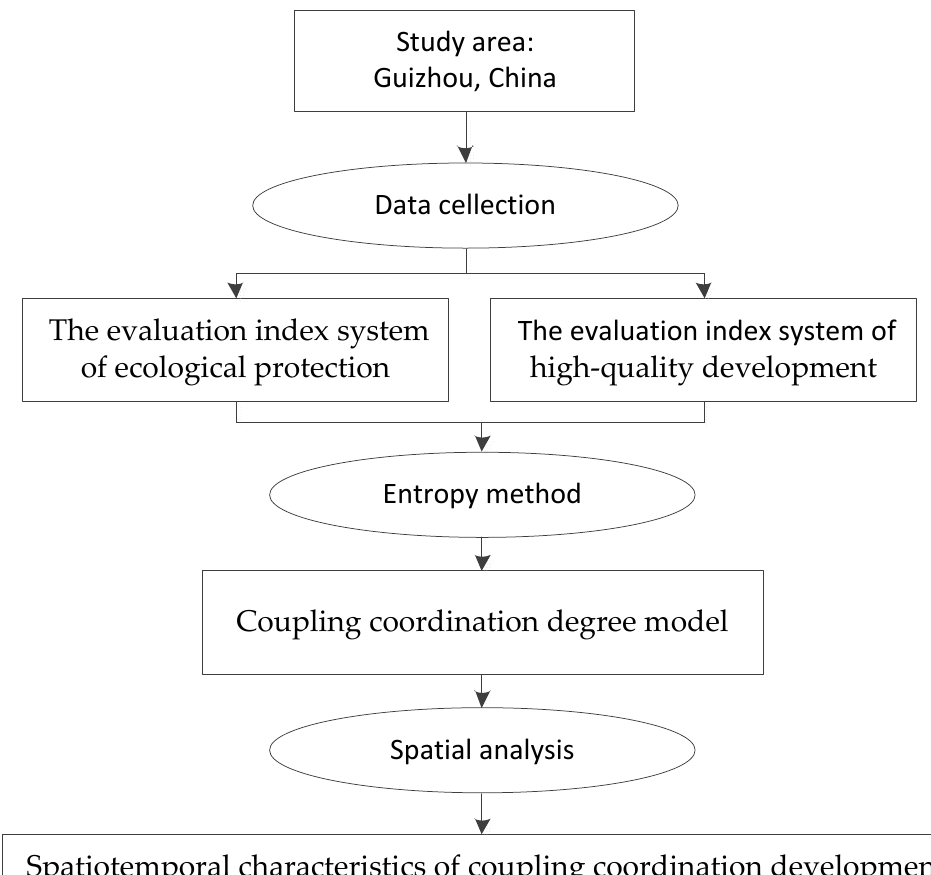
Figure 1. Workflow of the research.